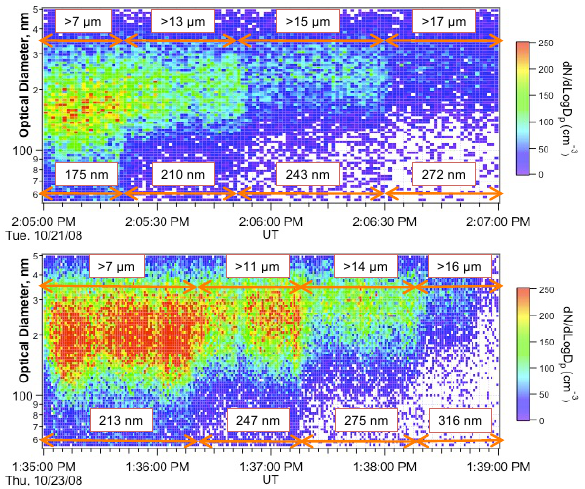
Fig. 8. Size distributions of droplet residual nuclei from droplets larger than different diameters as noted on the top of plots. Mean residual particle size is shown at bottom of plots. Top plot is from C-130 flight 3 (21 October 2008) and bottom is from flight 4 (21 October 2008).